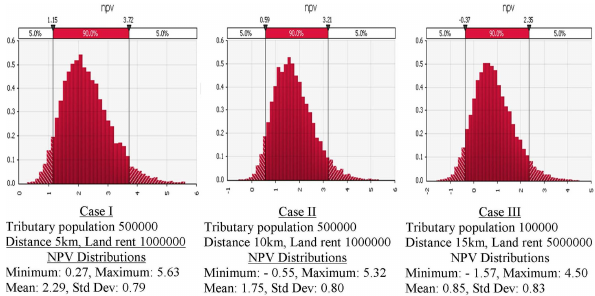
Table 6. Parameters for the simulation. Sl Symbol Item Unit Variation of data High Average Cost INR Mean and standard deviations are derived for ANN for each case